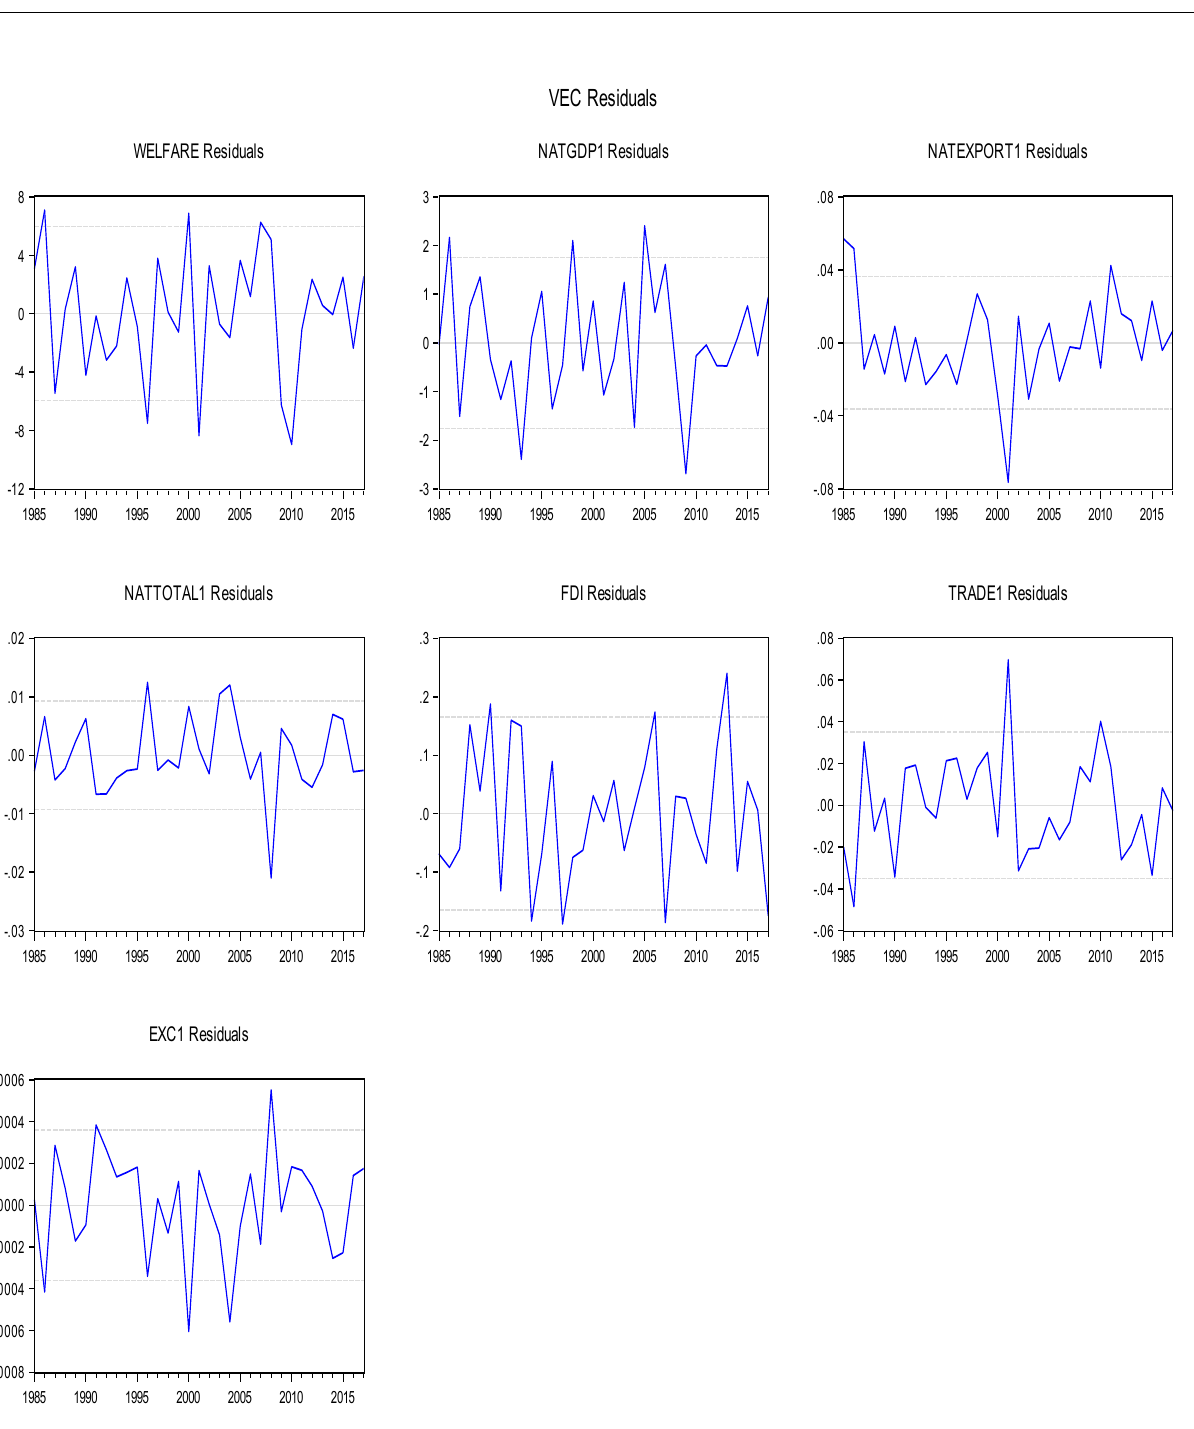
Figure A1. Vector Error Correction Residuals.